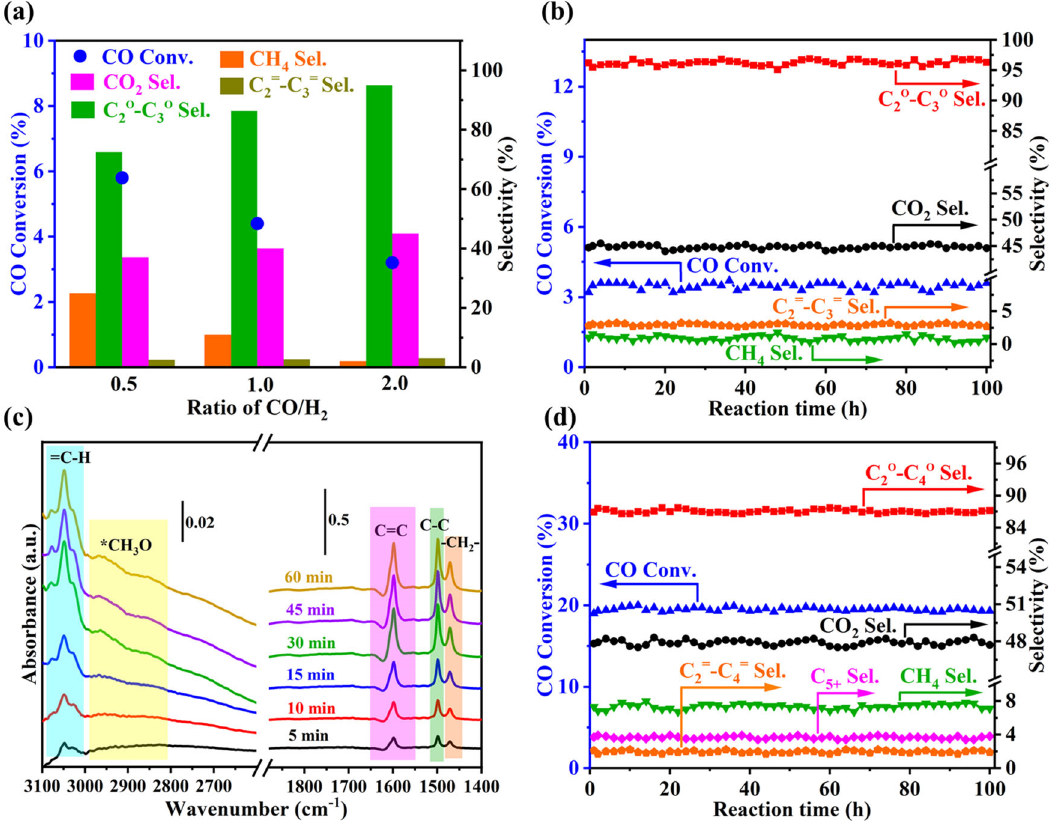
Fig. 6 | Syngas conversion over Mo 3 S 4 @HZSM-5. a Effect of CO/H 2 ratio on CO conversion and product distribution (260 o C, 4MPa, 4,000mLg cat − 1 h − 1 ); b Prolonged test of syngas conversion over Mo 3 S 4 @HZSM-5 (2CO/H 2 , 260°C,